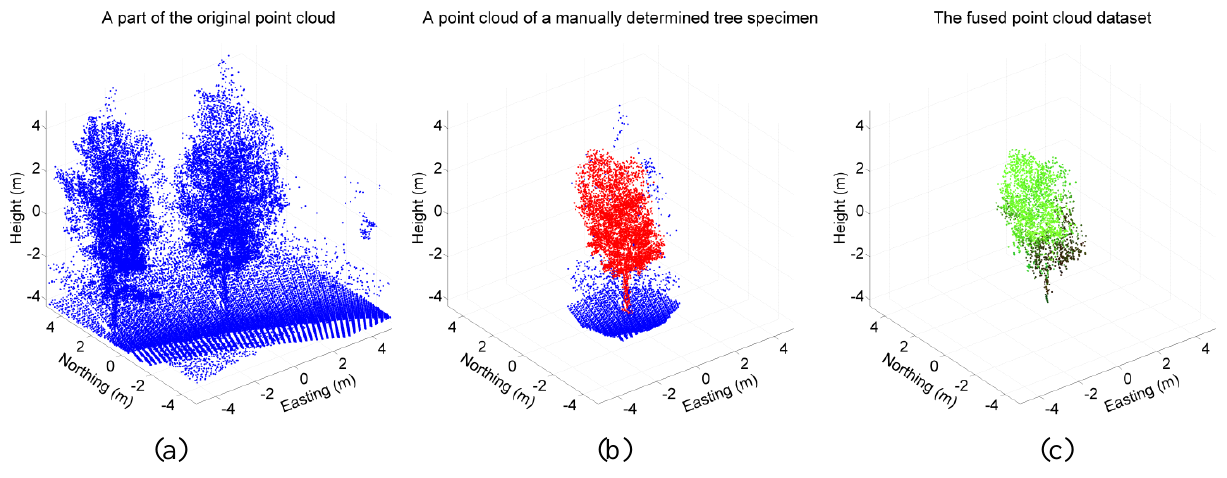
Figure 4 . Data fusion process. (a) A part of the laser point cloud presenting a single tree specimen ( Sorbus hybrida ) set in the origin. (b) The same tree specimen after manual determination. The blue points represent the situation after 2D determination and the red points represent the outcome after an accurate 3D determination. These points are used in derivation of the height statistics of the tree specimen that were used in LiDAR-derived feature classification (Section 4.1). (c) A fused point cloud. Overlap between each determined laser point and hyperspectral pixels has been tested and all overlapping laser points have been given an individual colour spectrum. The average of all mapped spectra were used in hyperspectral classification (Section